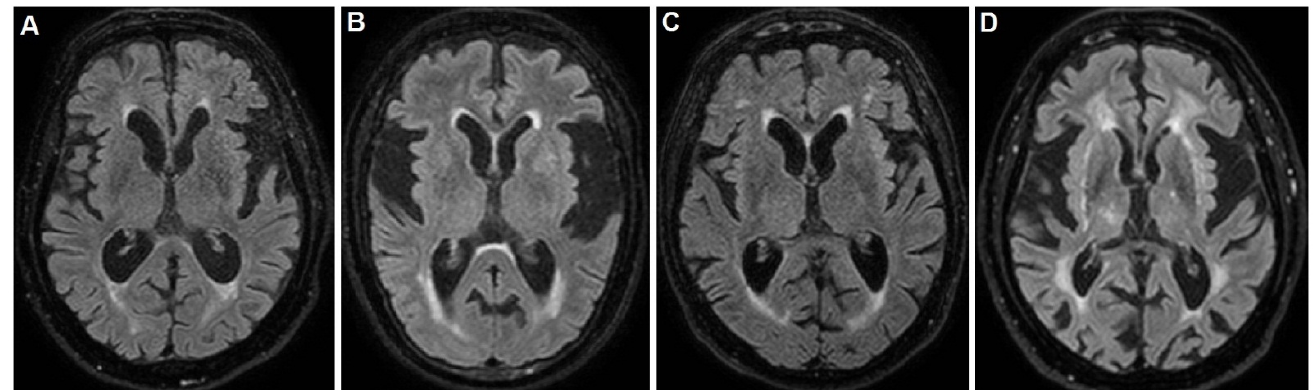
Figure 1. Brain magnetic resonance imaging (MRI) short tau inversion recovery (STIR) sequences of ( A ) patient 1: note the enlargement of the ventricular system and subarachnoid spaces with mild hyperintensity of the occipital horns periventricular white matter; ( B ) patient 2: note the enlargement of subarachnoid spaces with diffuse deepening of the cortical sulci and a thinning of the cortical mantle, especially at the fronto-temporal lobes. The hyperintensity of the occipital horns periventricular white matter is also visible; ( C ) patient 3: note the slight diffuse shrinkage of the subcortical grey matter with several hyperintense lesions at semioval centers; ( D ) patient 4: note the subcortical chronic ischemic lesions with vascular encephalopathy and periventricular diffuse hyperintensity. Note the atrophy of insula as a common feature of these